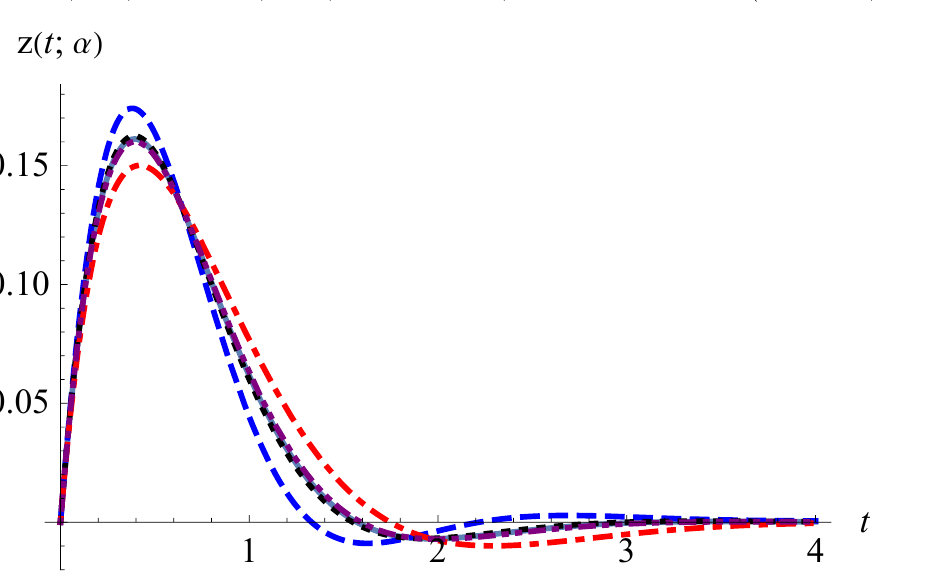
Figure 19. Curves of z ( t ;1 ) (solid line) and residue contribution z R ( t ; α ) for α = 0.9 (dash line), 0.99 (dot line), 1.1 (dot-dash line), 1.01 (dot-dot-dash line), where b = 4 and c = 8 ( b 2 − 4 c < 0).